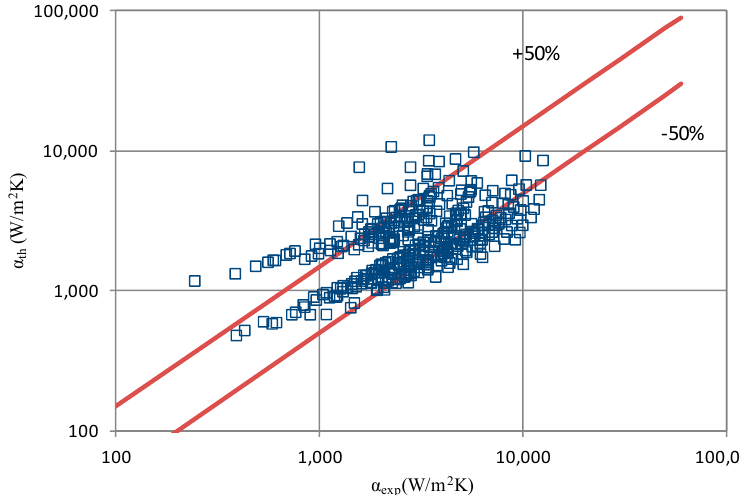
Figure 14. Comparison of the experimental research results on the heat transfer coefficient α with the results of the calculations according to correlation of Rahman–Kariya–Miyara [10] for HFE 7000 refrigerant.